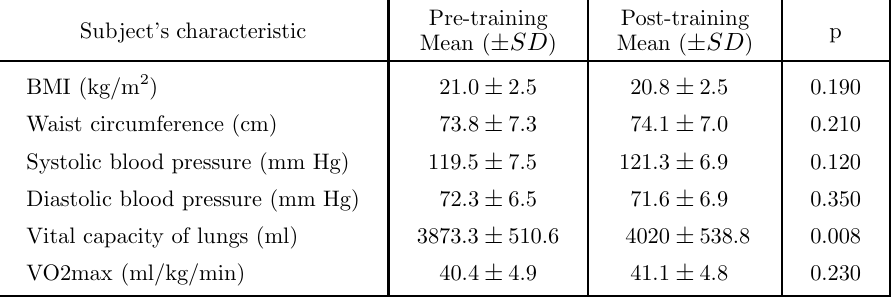
Table 2. Female characteristics pre-training and after 30 weeks of SAT (n = 15)